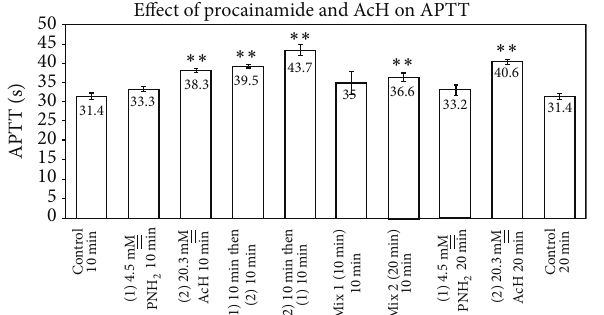
Figure 8: Effect of procainamide and acetaldehyde upon APTT ( 𝑛 = 6 ; 𝑃 = 0.0001 for AcH; for 1 procainamide, 2 AcH; and for 1 AcH, 2 procainamide; 𝑃 = 0.0035 for the 20 min premix of procainamide with AcH and is n.s. (0.3) for the 10min premix).